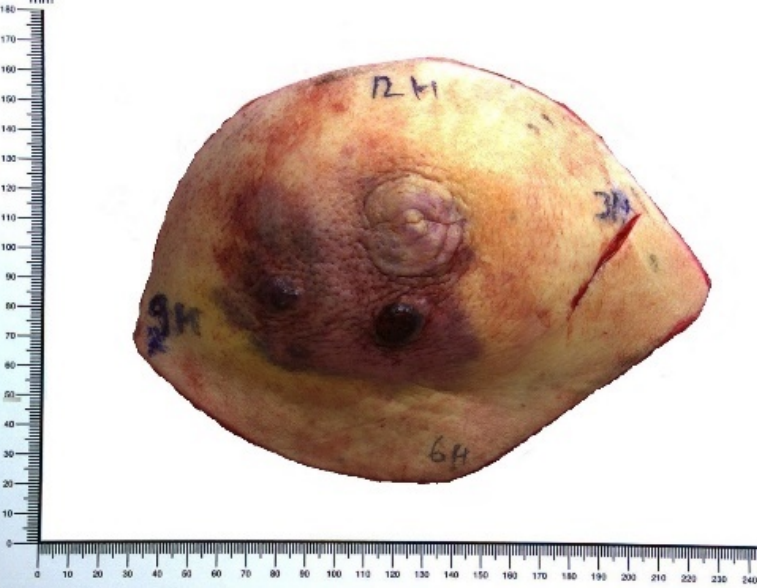
Figure 2. Surgical mammary specimen of radiation-induced breast angiosarcoma. Note violet, congestive skin and subcutaneous tumoral infiltration. Morphological cytologic and histologic findings are shown in Figure 3.